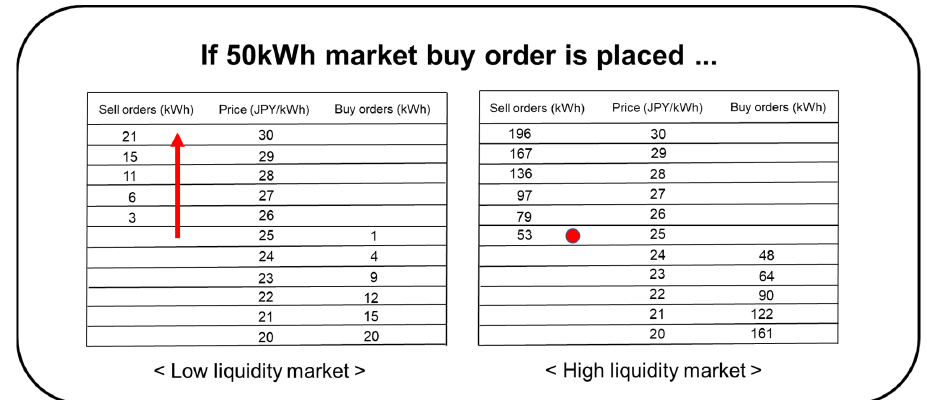
Figure 3. An illustrative example of order books for electricity trading. The left order book has low liquidity, which means that there are few limit orders, and the right order book has high liquidity, with many orders around the current market price of 25 JPY/kWh. If someone attempts to purchase 50 kWh at once as a market order, the market electricity price soars up to 30 JPY/kWh in the low liquidity case; on the other hand, in the right high-liquidity case, all of the 50 kWh power can be procured at the same price of 25 JPY/kWh.